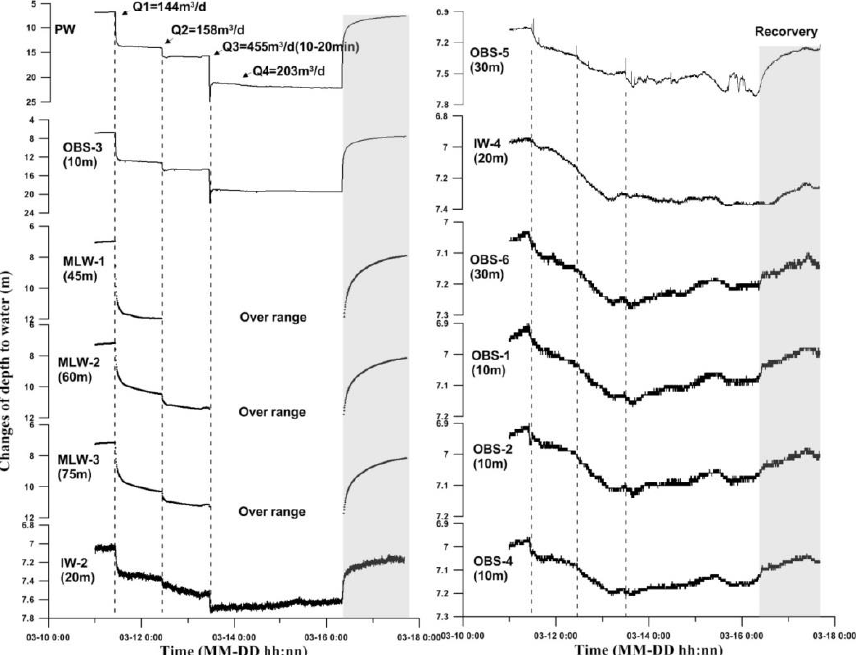
Figure 4. Changes in water level of the observational wells during the pumping test. The number in parentheses refers to the distance from the pumping well.